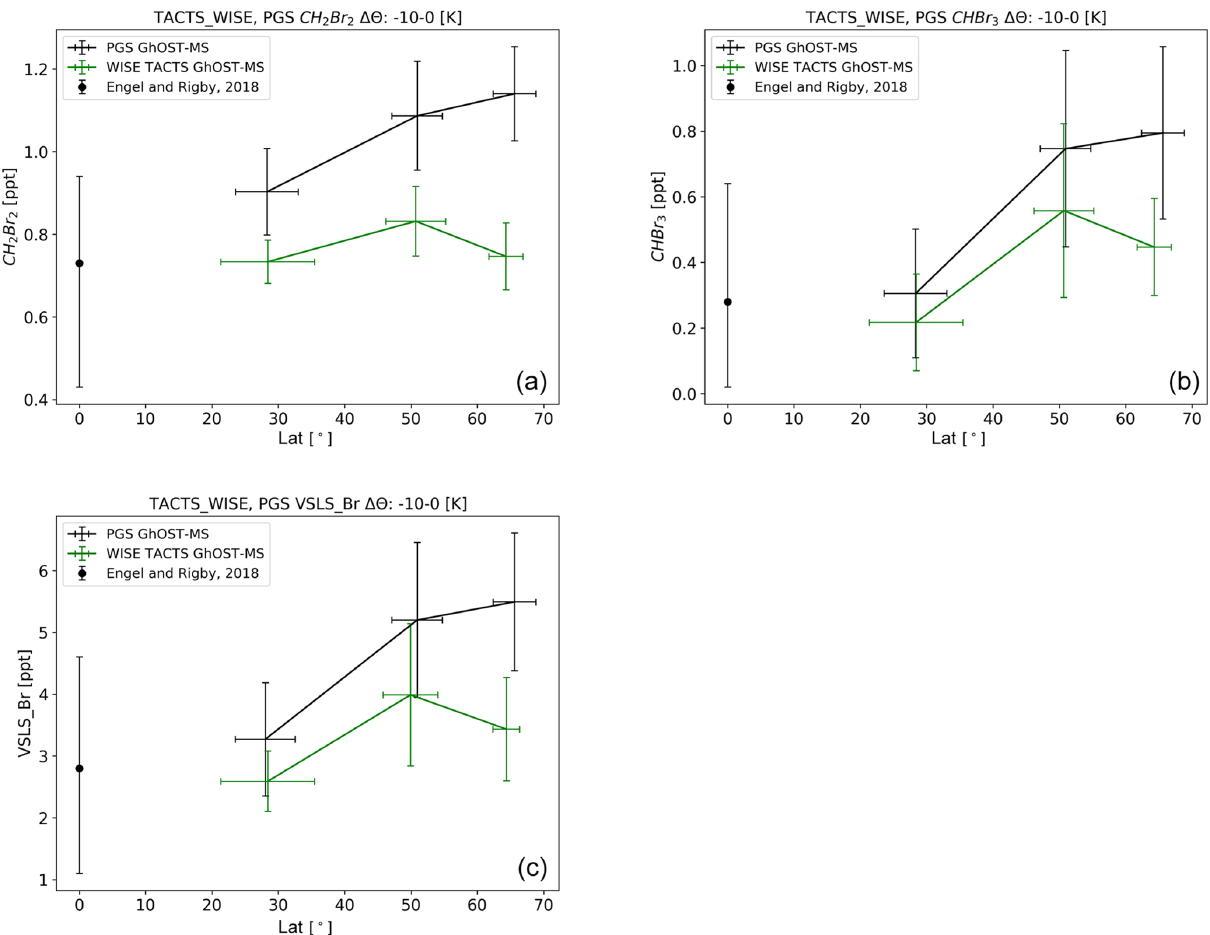
Figure 6. Latitudinal cross section of CH 2 Br 2 (a) , CHBr 3 (b) and total organic VSLS bromine (c) for all three campaigns, binned by latitude and averaged within 10K below the local dynamical tropopause. Also included are the reference mixing ratios for the tropical tropopause (Engel and Rigby,